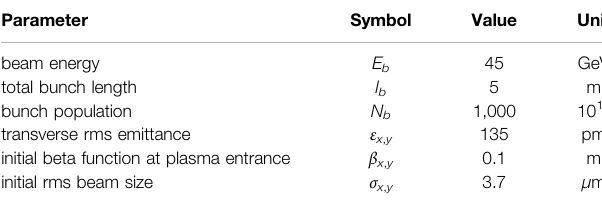
TABLE 1| Tentative parameters ofthe positron superbunch sent ontothe plasma target.